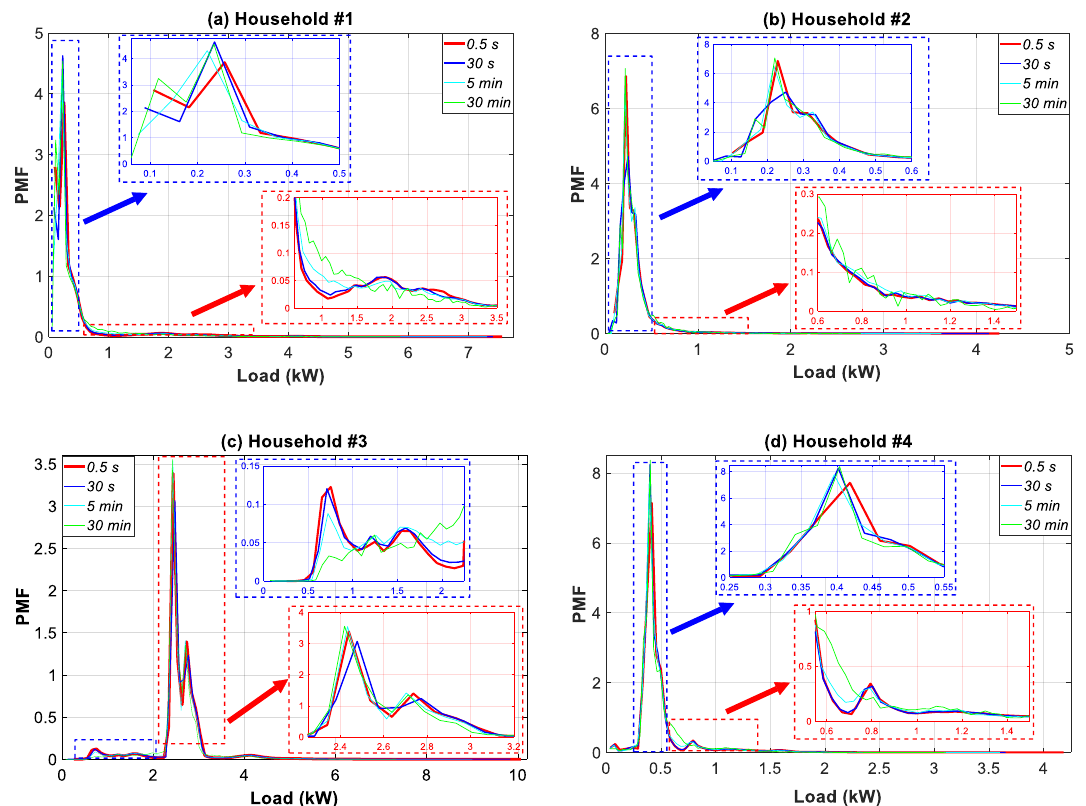
Figure 12. Annual empirical distribution of the consumption load profile in households #1 to #4 for four data granularities.